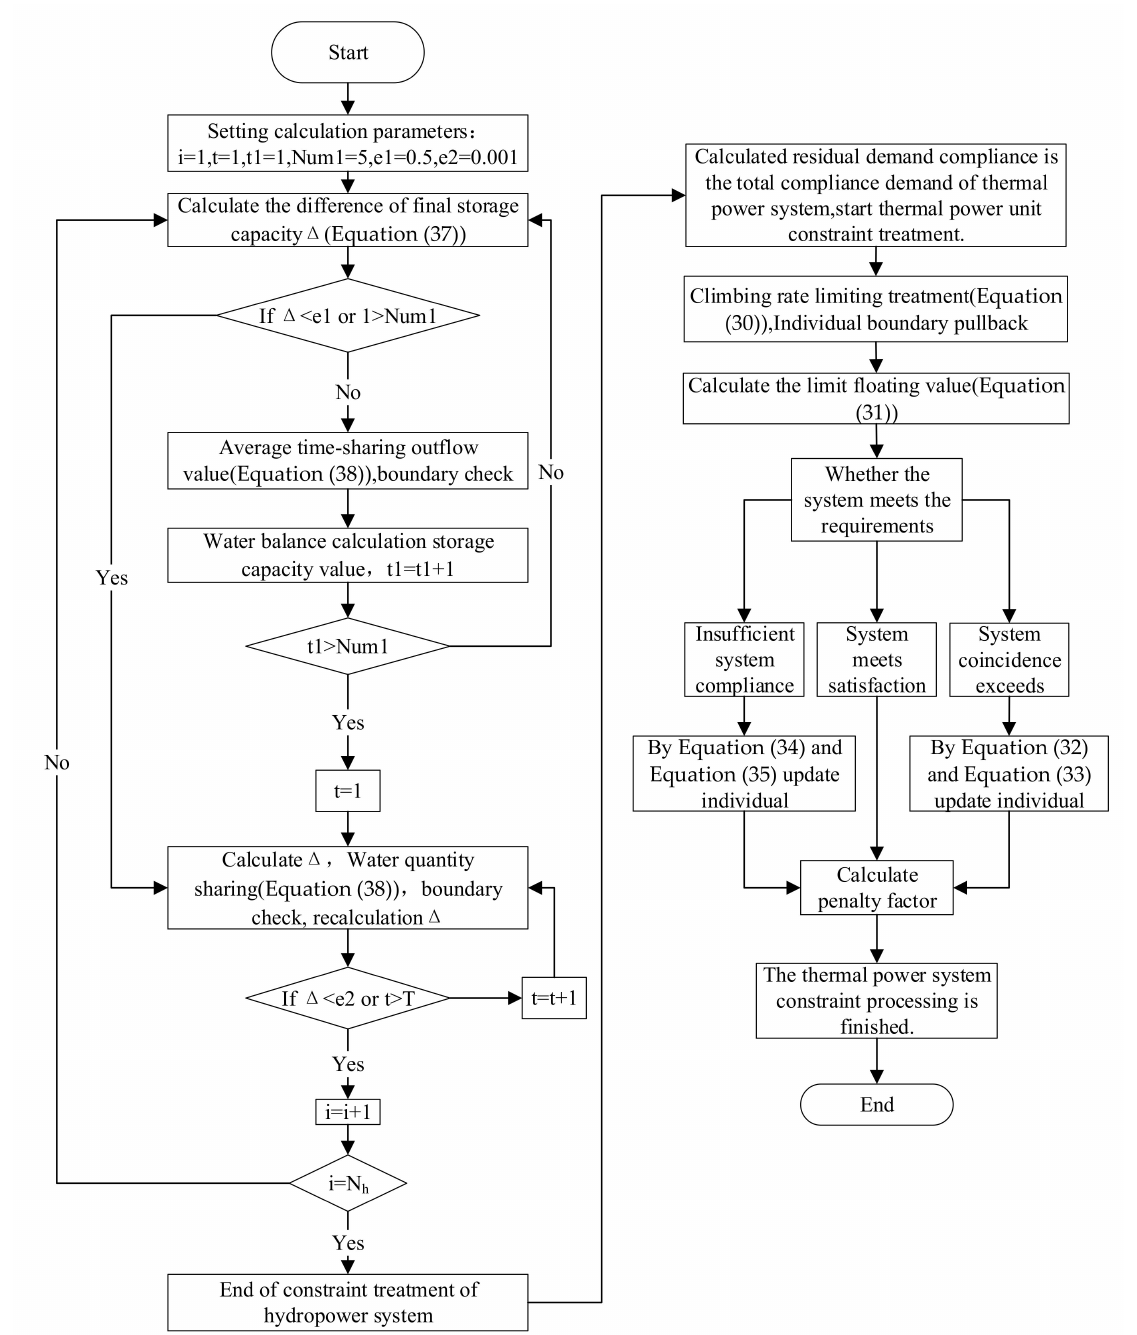
Figure 4. Flowchart of constraint processing of hydrothermal